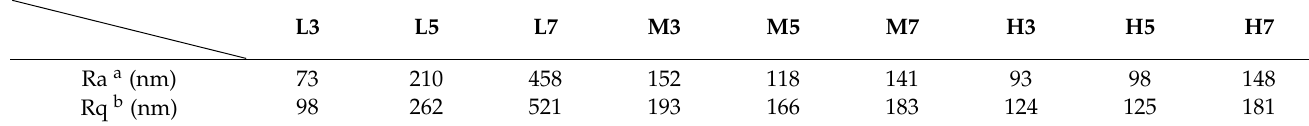
Table 2. Average step differences across the samples.